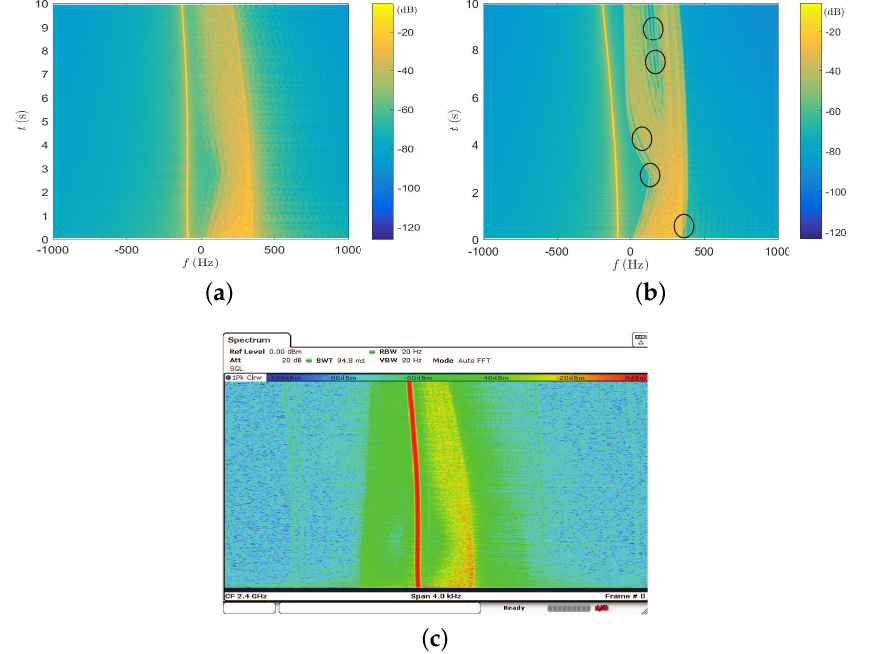
Figure 9. ( a ) The theoretical results of time-variant Doppler power spectrum density (DPSD), ( b ) the simulated time-variant DPSD of the model in [17], and ( c ) the measured time-variant DPSD of proposed